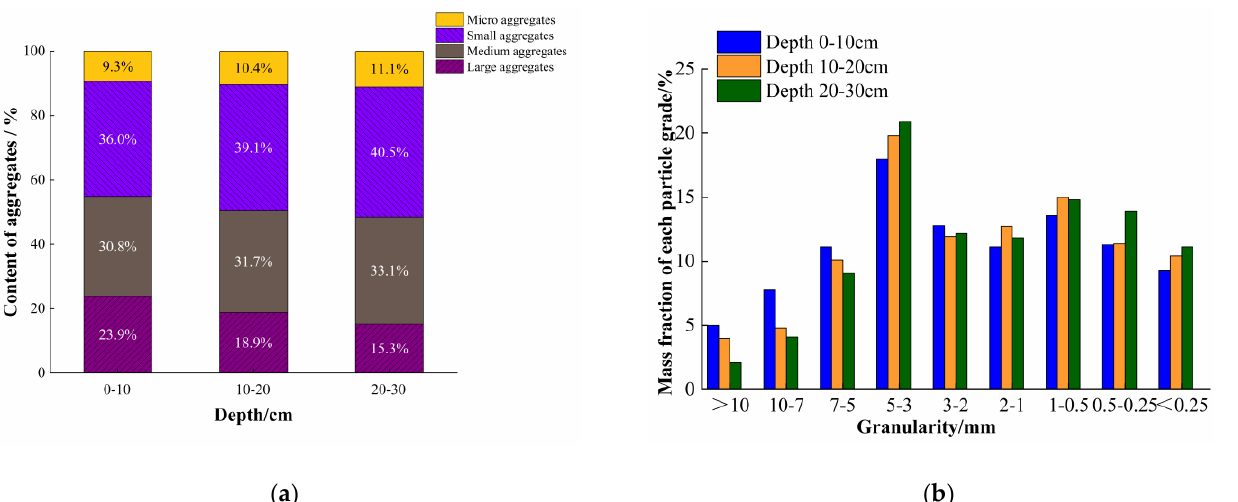
Figure 8. Distribution characteristics of aggregates. ( a ) Effect of depth on aggregates’ content; ( b ) effect of depth on the particle size of aggregates.